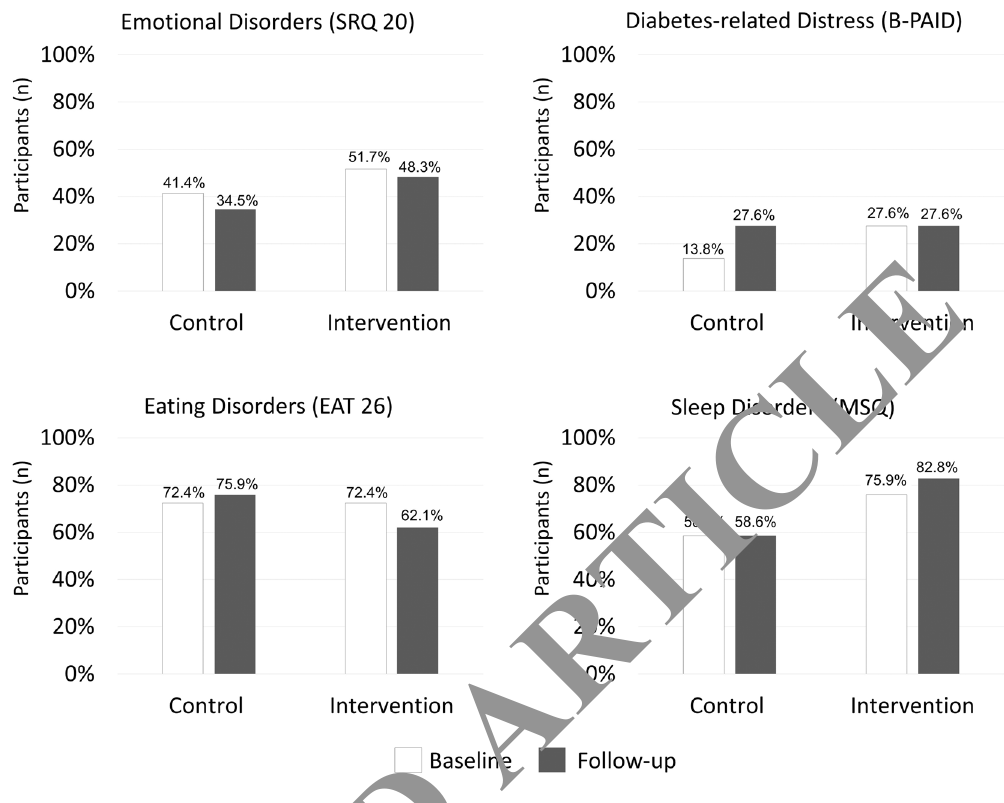
Figure 2. Participants with positive screening for mental health disorders based on cutoff values of the questionnaires. For the evaluation of emotional disorders, a score greater than or equal to 7 on SRQ 20 is considered positive. Diabetes-related emotional distress is considered when the B-PAID score is greater than or equal to 40. The presence of positive screening for an eating disorder is considered when the EAT 26 score is greater than or equal to 20. A positive screening for sleep disorder is considered when a score greater than or equal to 31 is present in the MSQ. *P = 0.04 for comparison between groups after the intervention.